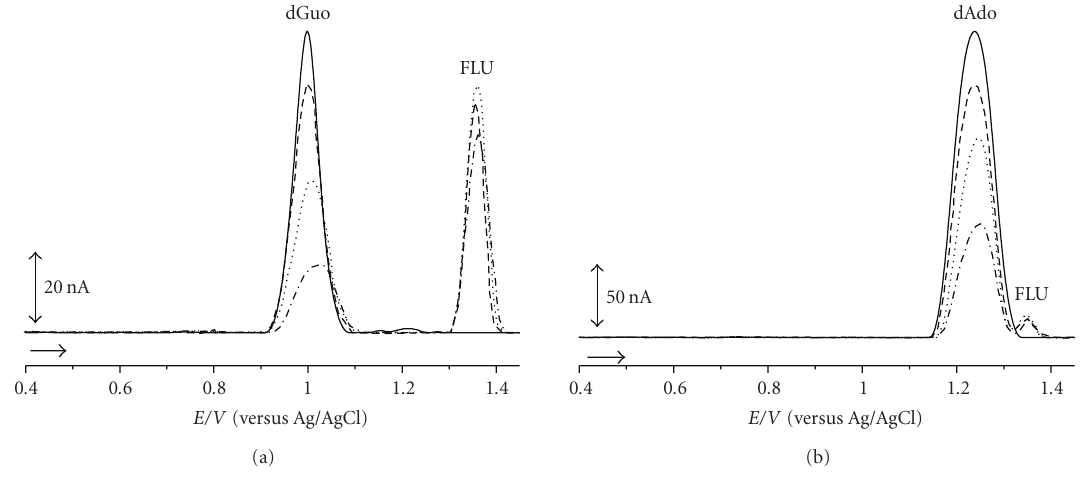
Figure 5: DP voltammograms baseline corrected in pH 4.5 0.1M acetate bu ff er of 100 μ gmL − 1 : (a) Poly[G] and (b) Poly[A] (solid line) before and after incubation with 5 μ M FLU during (dashed line) 0h, (dotted line) 1 h, and (dash-dotted line) 3h. Pulse amplitude-50 mV, pulse width-70ms, and ν = 5mVs − 1 .